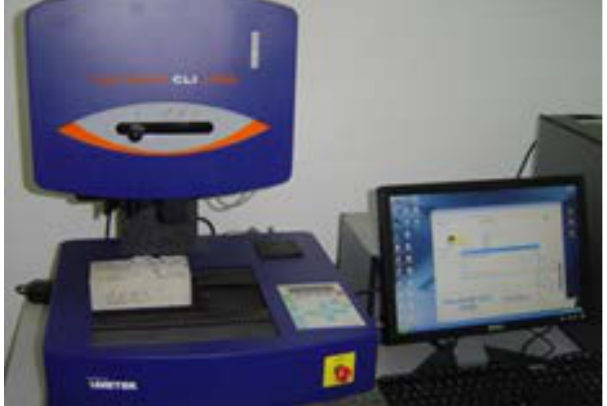
Figure 2. Talysurf CLI 1000 laser profilometer manufactured by Taylor Hobson for fast non-contact measurement of 3D surface topography.